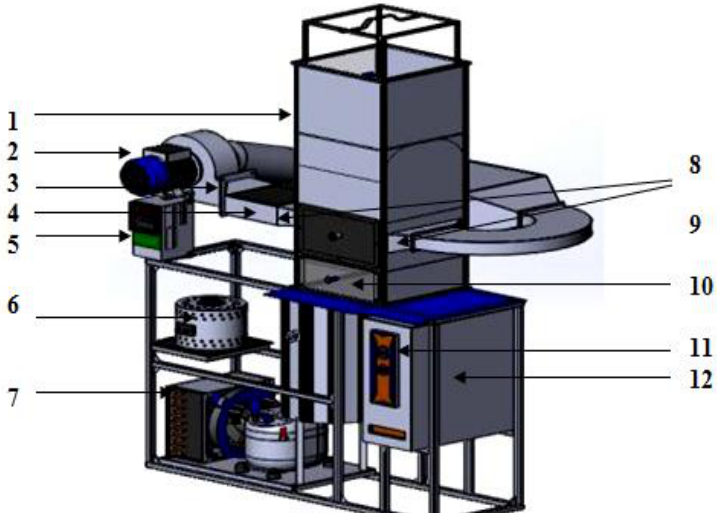
Figure 1. Experimental drying installation. 1 – drying chamber, 2 – electric motor, 3 – fan, 4